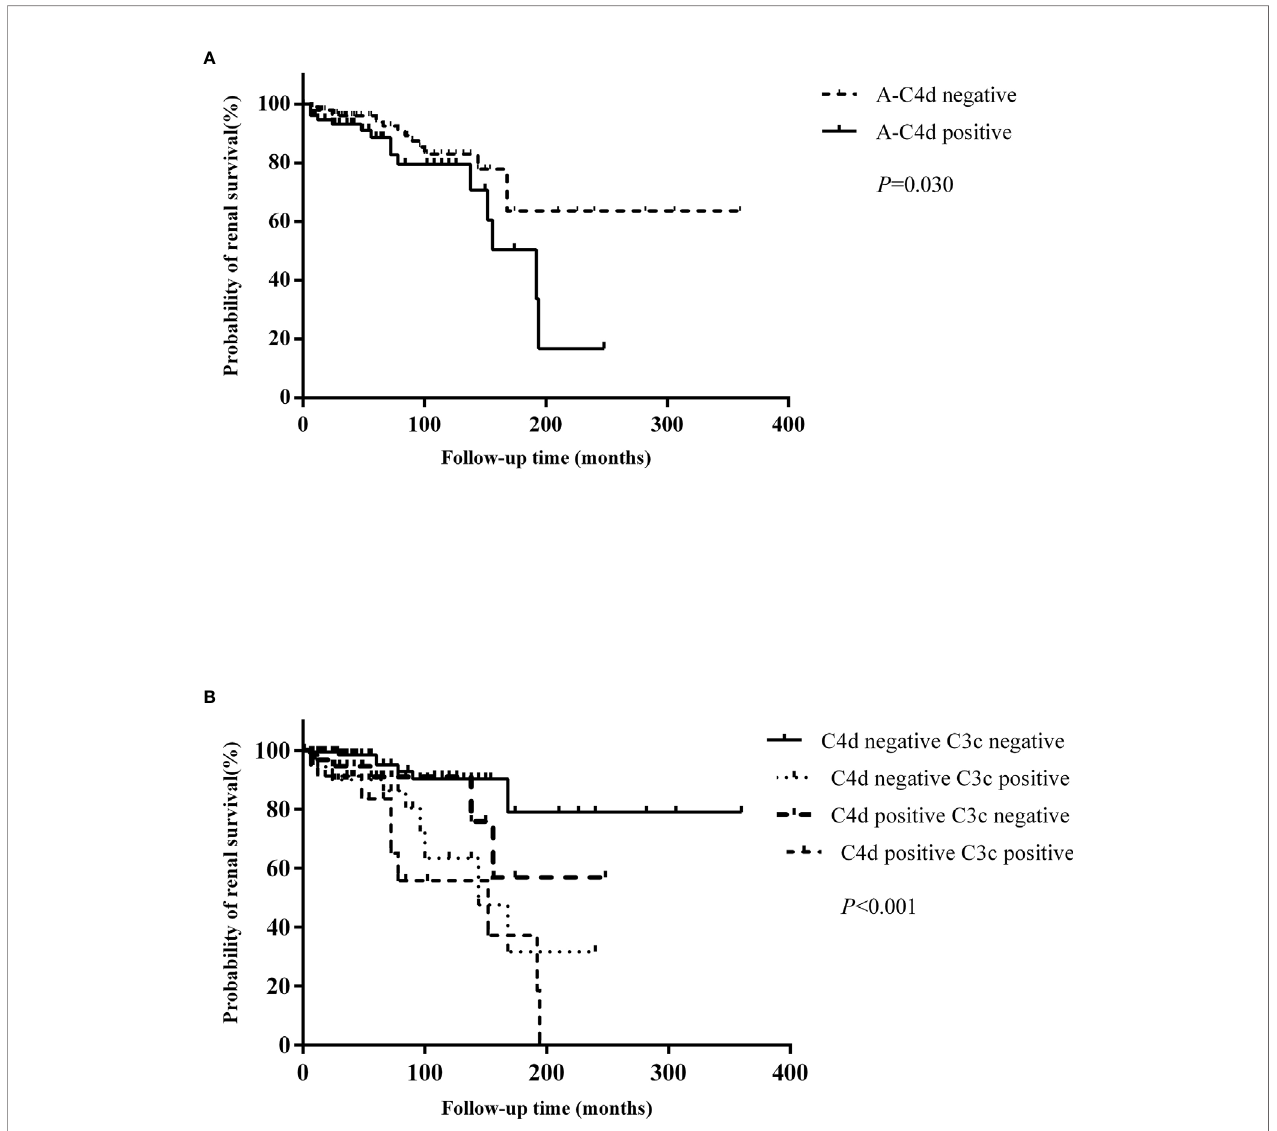
FIGURE 4 | (A) Comparison of renal outcomes between patients with and without arteriolar C4d deposition. (B) Comparison of renal outcomes between patients with and without arteriolar C4d and C3c